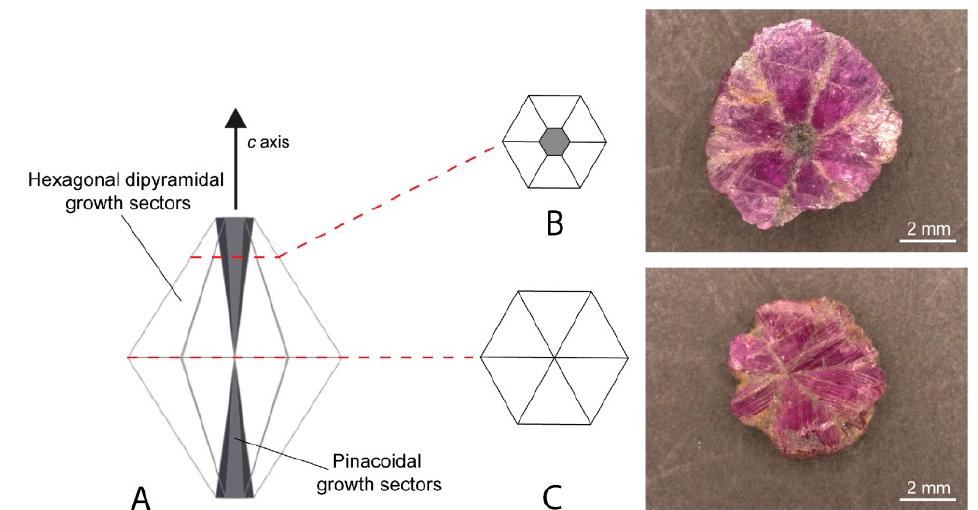
Figure 11. Variations of the ruby trapiche texture. ( A ) Variation of the core, which corresponds to the pinacoidal growth sectors (in grey). These sectors have a tapered shape and the core size varies as a function of the orientation of the cross-section; ( B ) aspect of the section near the vertex of the pyramid; and ( C ) aspect of the section if cut in the vertex plane. Photos by Isabella Pignatelli of two trapiche rubies from Mong Hsu, Myanmar.